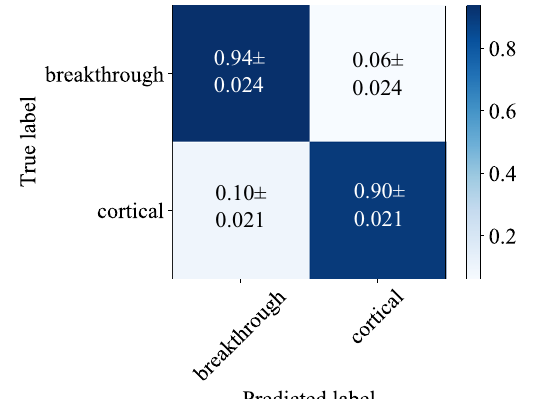
Figure 4. The normalized confusion matrix for a rectangular sliding window size of length L = 4410 samples which corresponds to a time frame of 100ms , recorded in the greater trochanter position.